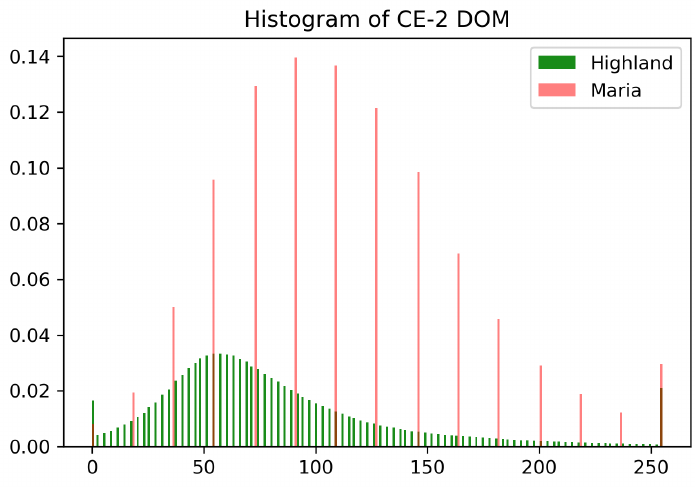
Figure 6. Histogram of CE-2 DOM in Maria and